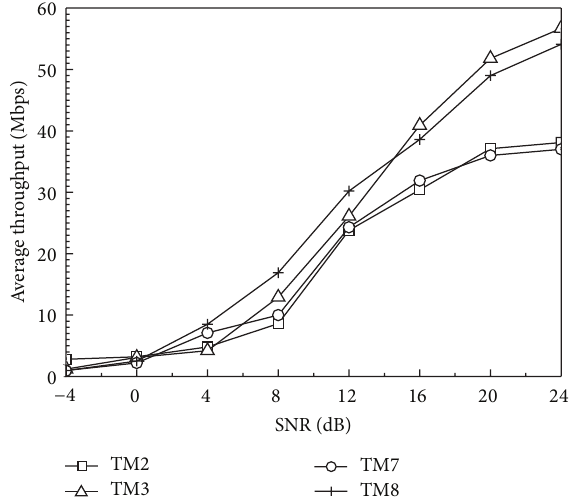
Figure 6: The downlink average throughput in the field trail.